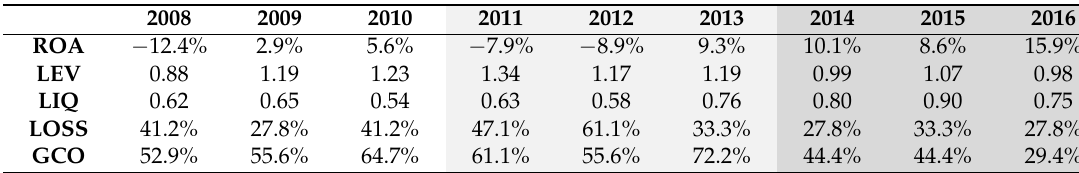
Table 8. Evolution of risk